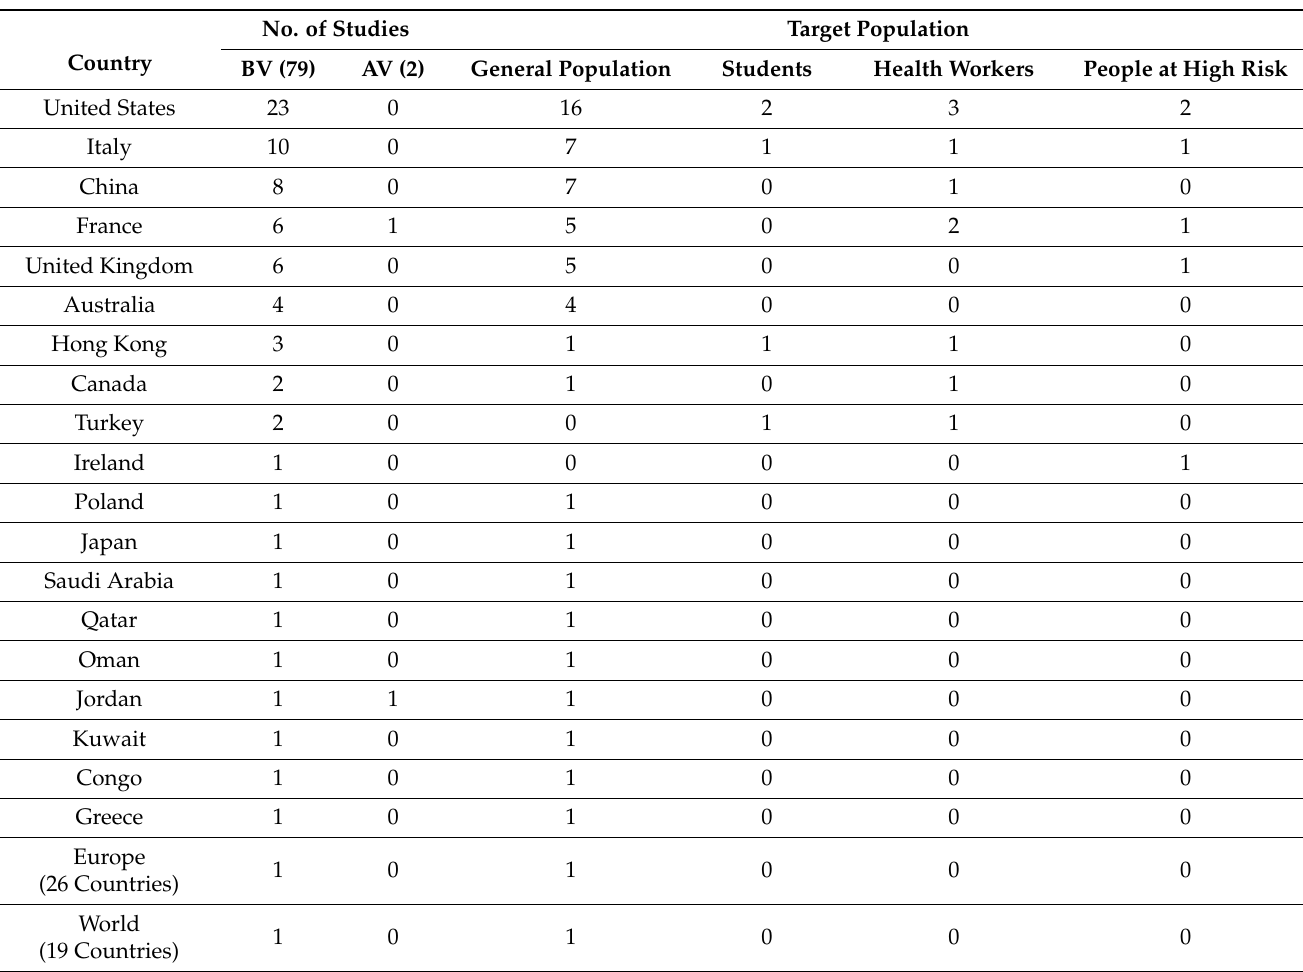
Table 2. Characteristics of the included